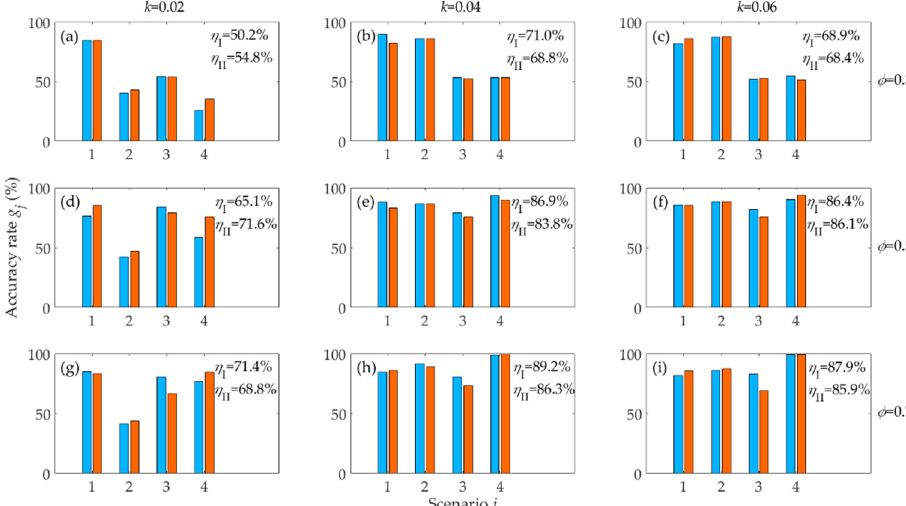
Figure 8. Accurate rates of trend tests by the MMK test and OW operation in simulation experiment 2 at the 5% significance level. (Note: the length of STS is 50; k and ϕ are the trend slope and the autoregressive coefficient in simulation experiment 2; Ⅰ and Ⅱ represent the results of the MMK test and OW operation, respectively; and the explanation for sub-figures ( a )–( i ) can be referred to Figure 7.)